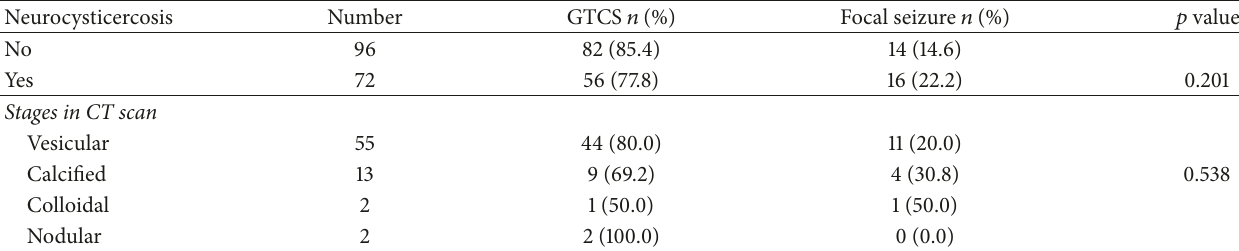
Table 2: Different stages of NCC in children in relation to types of